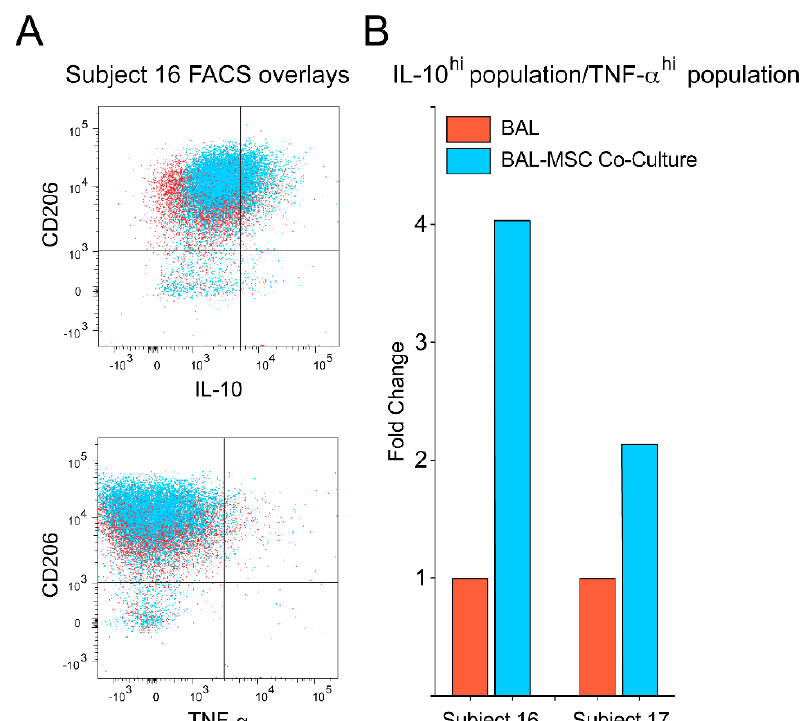
Figure 3. Intracellular cytokine ratios of alveolar macrophages (AMs) suggest a change from M1 (pro-inflammatory) to M2 (anti-inflammatory) status after co-culture with bone marrow stromal cells (MSCs). ( A ) Bronchoalveolar lavage (BAL) cells are depicted in red, BAL cells from co-cultures are pictured in blue. The co-cultured BAL cells demonstrate a clear shift towards the right, indicating an increase in the mean fluorescent intensity (MFI) of the IL-10 + population, and upwards, indicating an increase in the MFI of CD206 in these cells. Due to the lower percentage of cells producing TNF- α , a leftward shift is not as evident, although an upward shift indicating increased MFI of CD206 in these cells is present. ( B ) The fold change of the ratio of IL-10 to TNF- α for the BAL–MSC co-culture is shown for both subjects (sarcoidosis subjects 16 and 17). BAL cells cultured alone are depicted by the red bars (the ratio was converted to a value of 1), and co-cultured BAL cells are depicted by the blue bars (representing the fold increase of the ratio). The bar graph shows that—although not to the same extent—the BAL cells shifted towards a more anti-inflammatory state in both subjects.